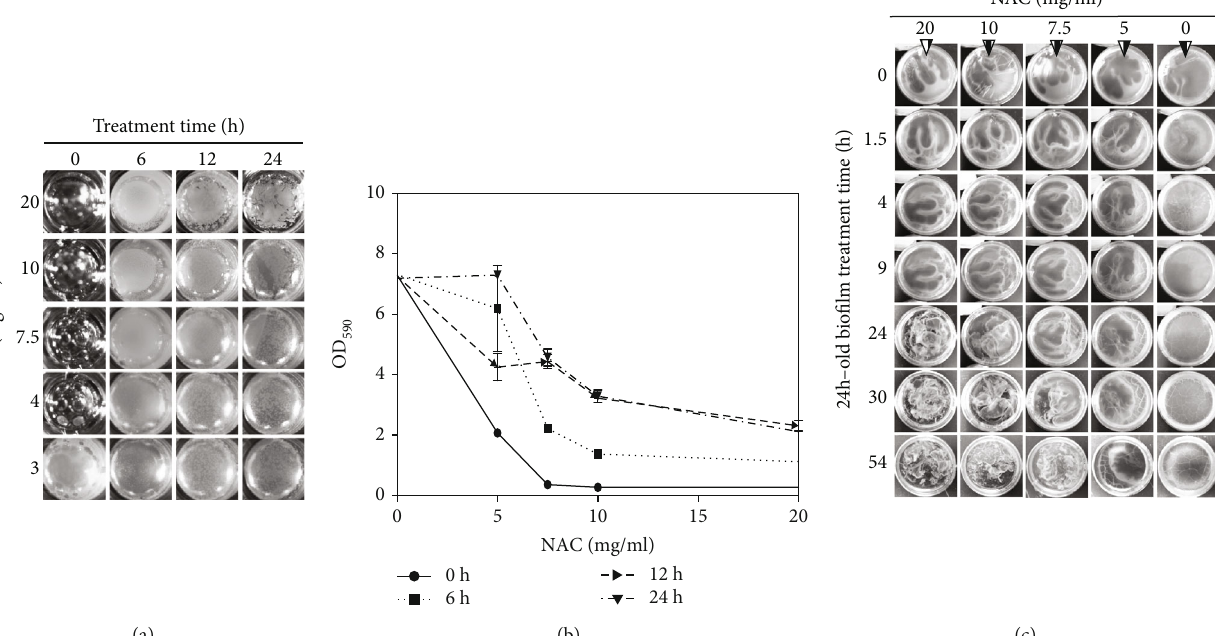
Figure 2: The e ff ect of NAC on bio fi lm development and dismantling. (a) Microbiome taken from the chronic wounds and grown in 96-well microtiter plates. Concentrations of NAC ranging from 3 to 20mg/ml were applied to the cultures at the times indicated (0, 6, 12, and 24 h). The pictures shown were taken at 48 h after initiation of the culture. When ≥ 4mg/ml NAC were applied to the culture at 0 h, the bio fi lm never developed. When ≥ 10 mg/ml of NAC was applied at 6, 12, and 24h after culture initiation, bio fi lm formation was visibly altered or became fragile and disrupted. (b) At 48h, bio fi lm was stained with crystal violet (CV) and the absorbance at 590 nm was measured to quantify bio fi lm biomass. At 0 h, 5mg/ml application, 5 mg/ml NAC signi fi cantly reduced the appearance of bio fi lm, and when applied at 6 and 12 h, it was able to decrease bio fi lm production but not when applied at 24h. ≥ 10 mg/ml NAC or more signi fi cantly diminish bio fi lm formation. Three technical repeats with standard deviation as error bars for quantitative data. (c) The dose-dependent e ff ect of NAC on 24h old bio fi lm cultured in 35 mm petri dishes was recorded over time. 20mg/ml of NAC dismantled bio fi lm by 24 h; 10 and 7.5mg/ml of NAC were able to fully disrupt bio fi lm at 30 and 54h, respectively. 5 mg/ml NAC did not cause changes in existing bio fi